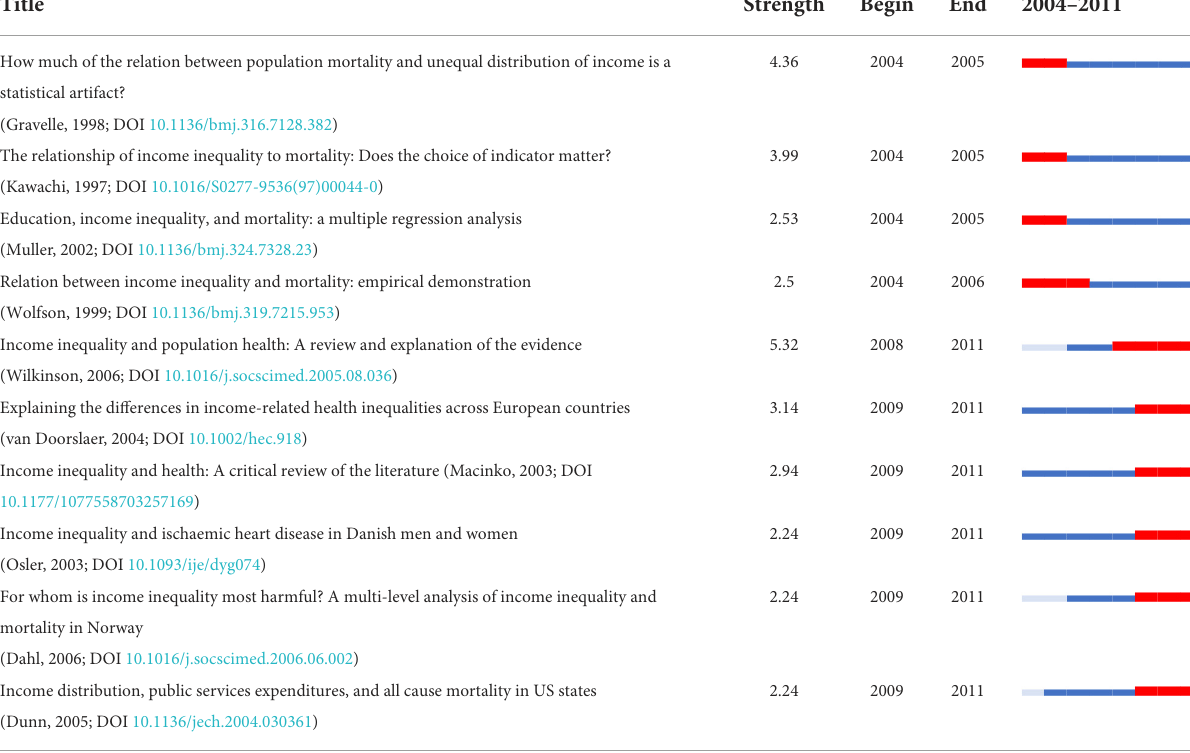
TABLE 6 Top 10 references with strongest citation bursts in